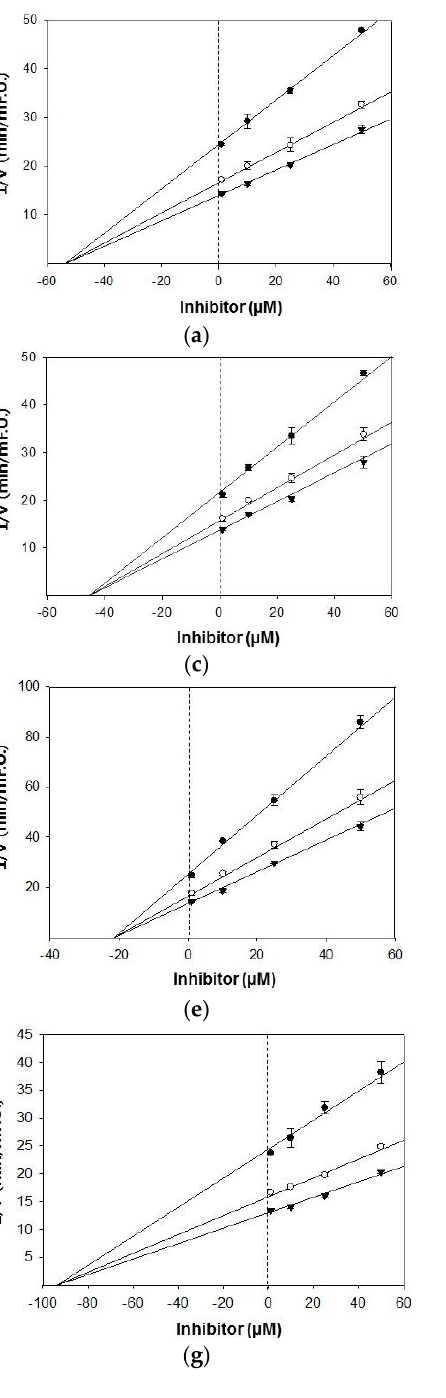
Figure 3. Dixon and Lineweaver–Burk plots for the inhibition of AChE by citrus flavanones. Dixon plots show the effects of the presence of different substrate concentrations: 250 nM (●), 500 nM ( ○ ), 750 nM ( ▼ ) for hesperetin ( a ); naringenin ( c ); and hesperidin ( e ). Lineweaver–Burk plots were analyzed in the presence of different inhibitor concentrations: 1 μM (●), 10 μM ( ○ ), 25 μM ( ▼ ), 50 μM ( ▽ ) for hesperetin ( b ); naringenin ( d ); and hesperidin ( f ). Dixon and Lineweaver–Burk plots for the inhibition of BChE by hesperidin. Dixon plots show the effects of the presence of different substrate concentrations: 250 nM (●), 500 nM ( ○ ), 750 nM ( ▼ ) for hesperidin ( g ). Lineweaver–Burk plots were analyzed in the presence of different inhibitor concentrations: 1 µ M ( ), 10 µ M ( ), 25 µ M ( (cid:72) ), 50 µ M (cid:35) ( (cid:53) ) for hesperidin ( h